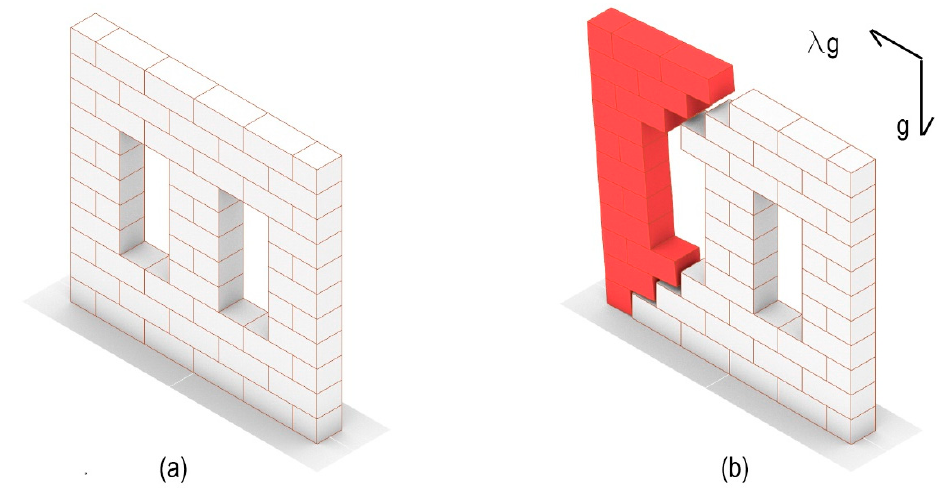
Figure 6. ( a ) Geometry and Load configurations; ( b ) failure mechanism obtained by using non-associative friction solu- tion